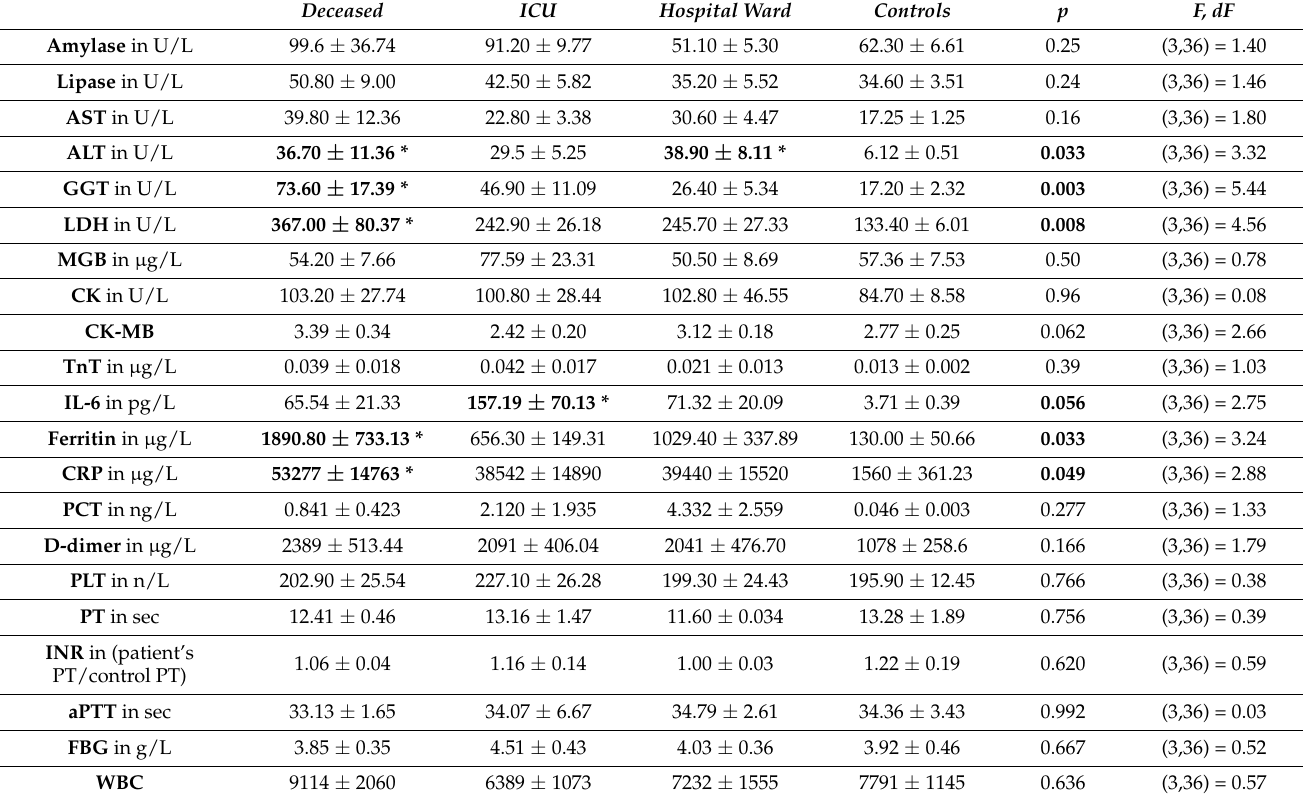
Table 4. ANOVA data for some routine blood parameters in all groups. Significant scores are shown in bold. The asterisks indicate significant differences with controls